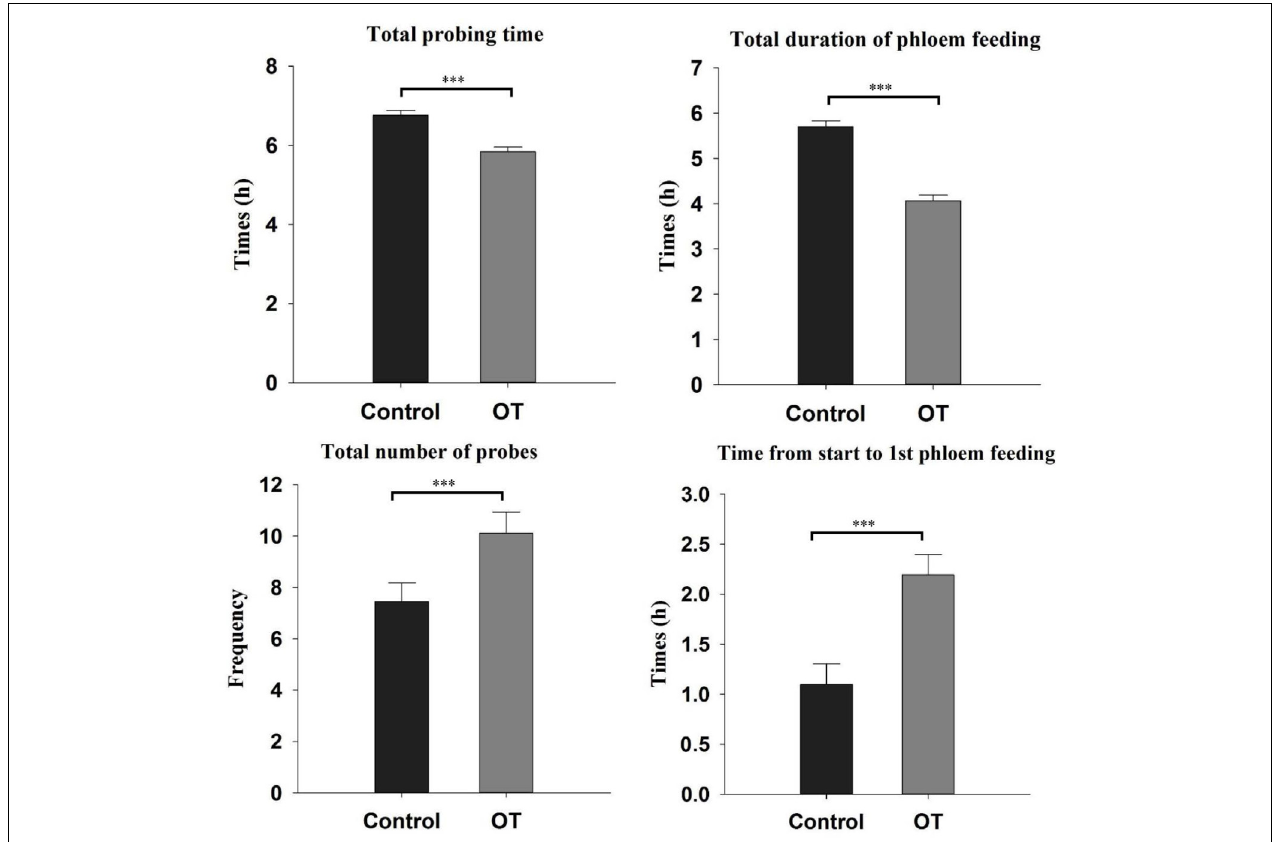
FIGURE 2 | Feeding behavior parameters of M. persicae on β -ocimene treated and control Chinese cabbages revealed by electrical penetration graph (EPG). OT, β -ocimene treated Chinese cabbage. Different letters over the bars designate a significant difference: ∗ P < 0.05, ∗∗ P < 0.01, ∗∗∗ P < 0.001.